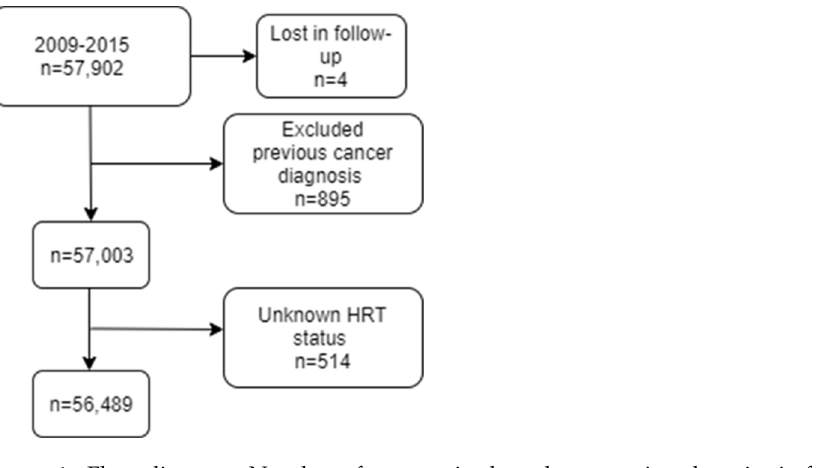
Figure 1. Flow diagram: Number of women in the cohort meeting the criteria for inclusion in the analysis.